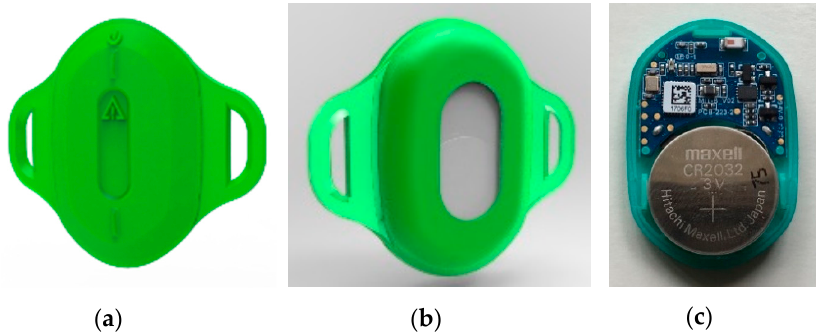
Figure 2. The BLE Tag. ( a ) Stereoscopic appearance; ( b ) back view; ( c ) internal